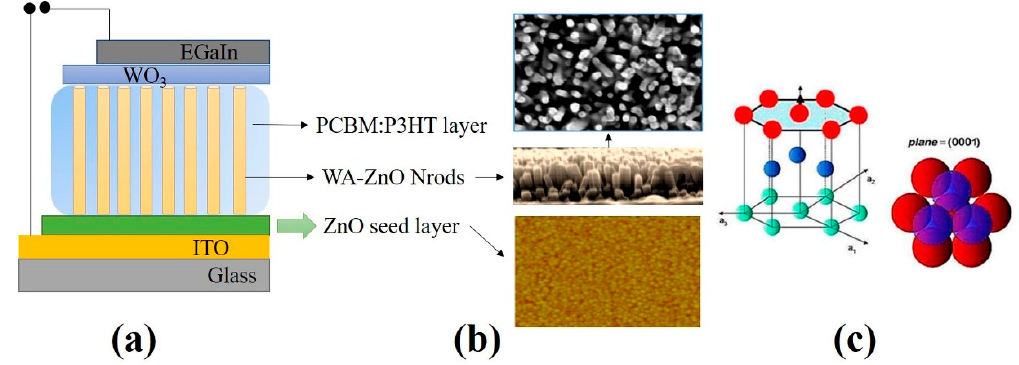
Figure 1. ( a ) The schematic diagram of the device structure, ( b ) WA-ZnO Nrods and ZnO seed layer morphology, and ( c ) WA-ZnO Nrod with hexagonal structure.